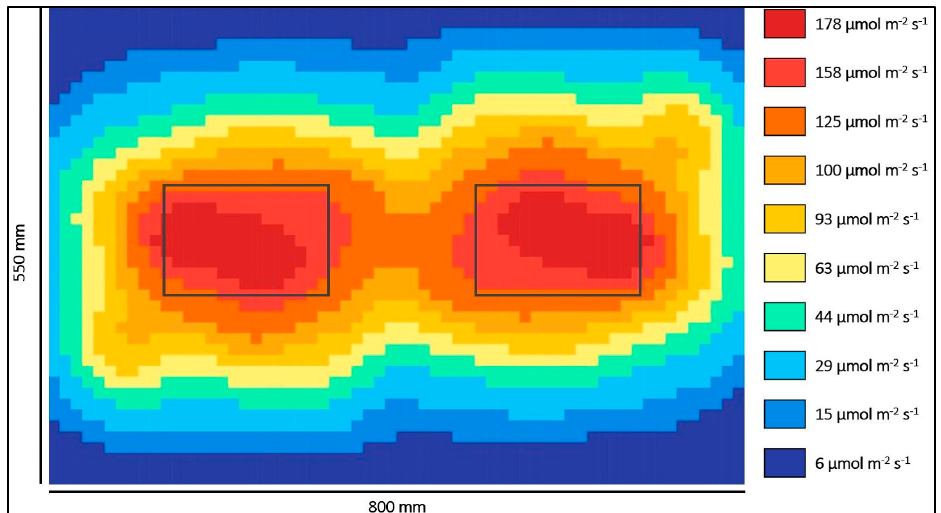
Figure 2. Estimated PPFD map under the LED module used for growth experiments, according to the producer’s software at a distance of 75 cm between the pots and the LED module. The active area used for the growth experiments is indicated by the two black rectangles.